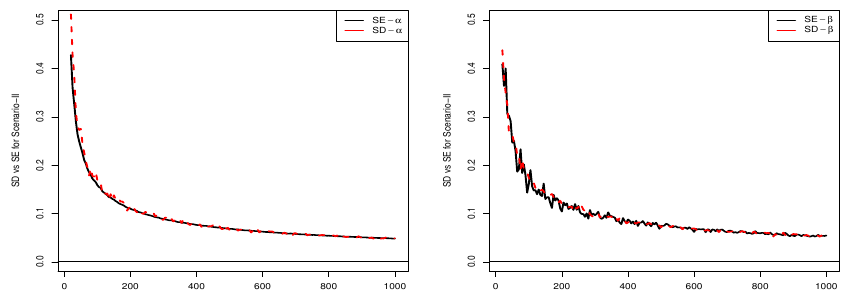
Figure 13. Comparison of SD and SE for the scenario-II.